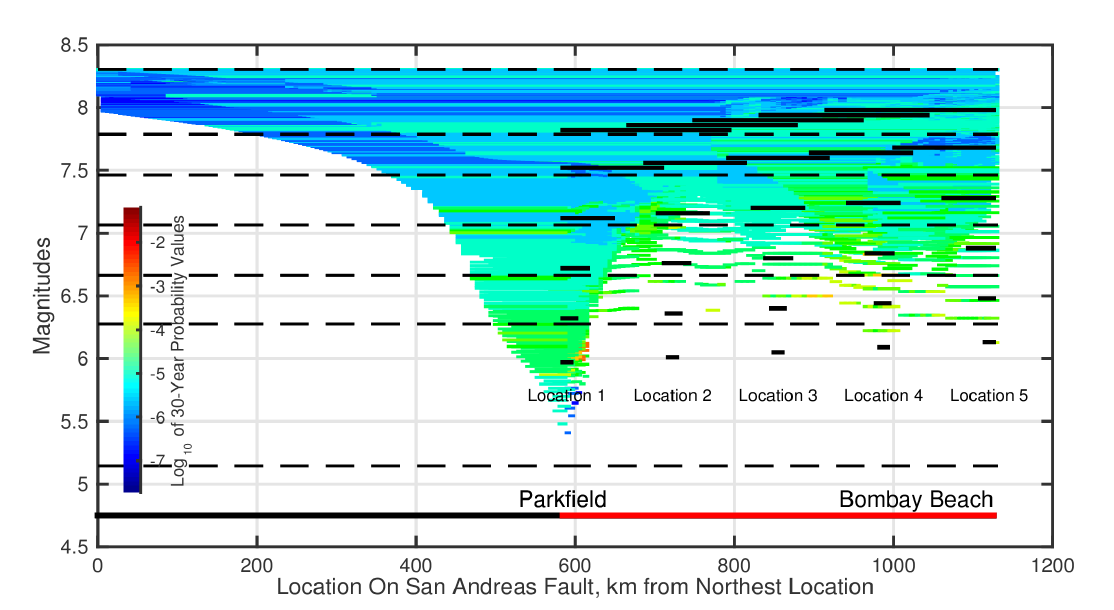
Figure 3. The 30 scenario earthquakes (shown in black) superposed on top of the forecast earthquakes from Figure 2. Two rupture directions are considered for each, bringing the total number of scenario earthquakes to 60. Dashed black lines demarcate the magnitude bins adopted in the case study. Colored lines demarcate UCERF’s plausible (“forecast”)